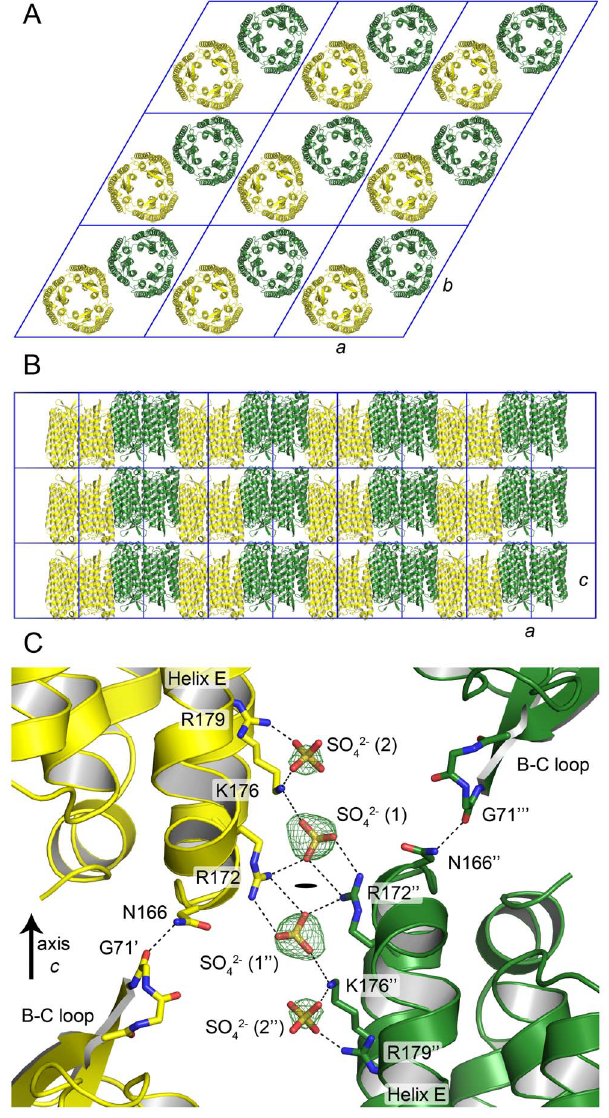
Figure 3. Hm BRI packing in hexagonal crystals. (A) Packing in the membrane plane. There are two trimers in the unit cell (shown in yellow and green) that are oriented in opposite directions. (B) Packing of the membrane-like layers. (C) Crystal contacts between the layers. The contacts rely on the ionic interactions between the SO 42 2 ions and the R172 and K176 side-chains, and on the hydrogen bond between the N166 side-chain of one protomer and the G71 backbone oxygen of another. A second putative SO 42 2 ion is observed close to the first one that interacts with K176 and R179 side-chains. Potential interactions are marked by dashed lines. F o -F c difference electron densities before the insertion of the ions into the model are shown at the level of 3 s . The symbols ’, ’’ and ’’’ denote different crystallographic symmetry-related HmBRI molecules. The black oval denotes the crystallographic symmetry rotation axis (C 2